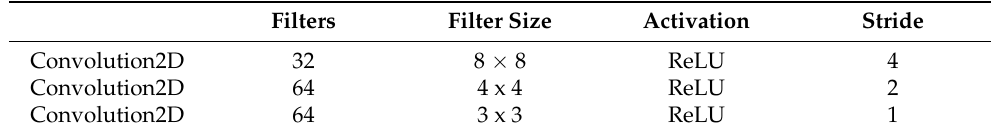
Table 4. Parameter of convolutional layer.